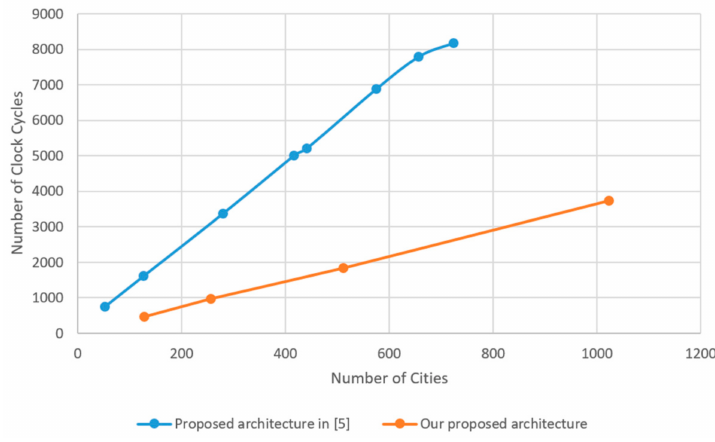
Figure 12. Speed